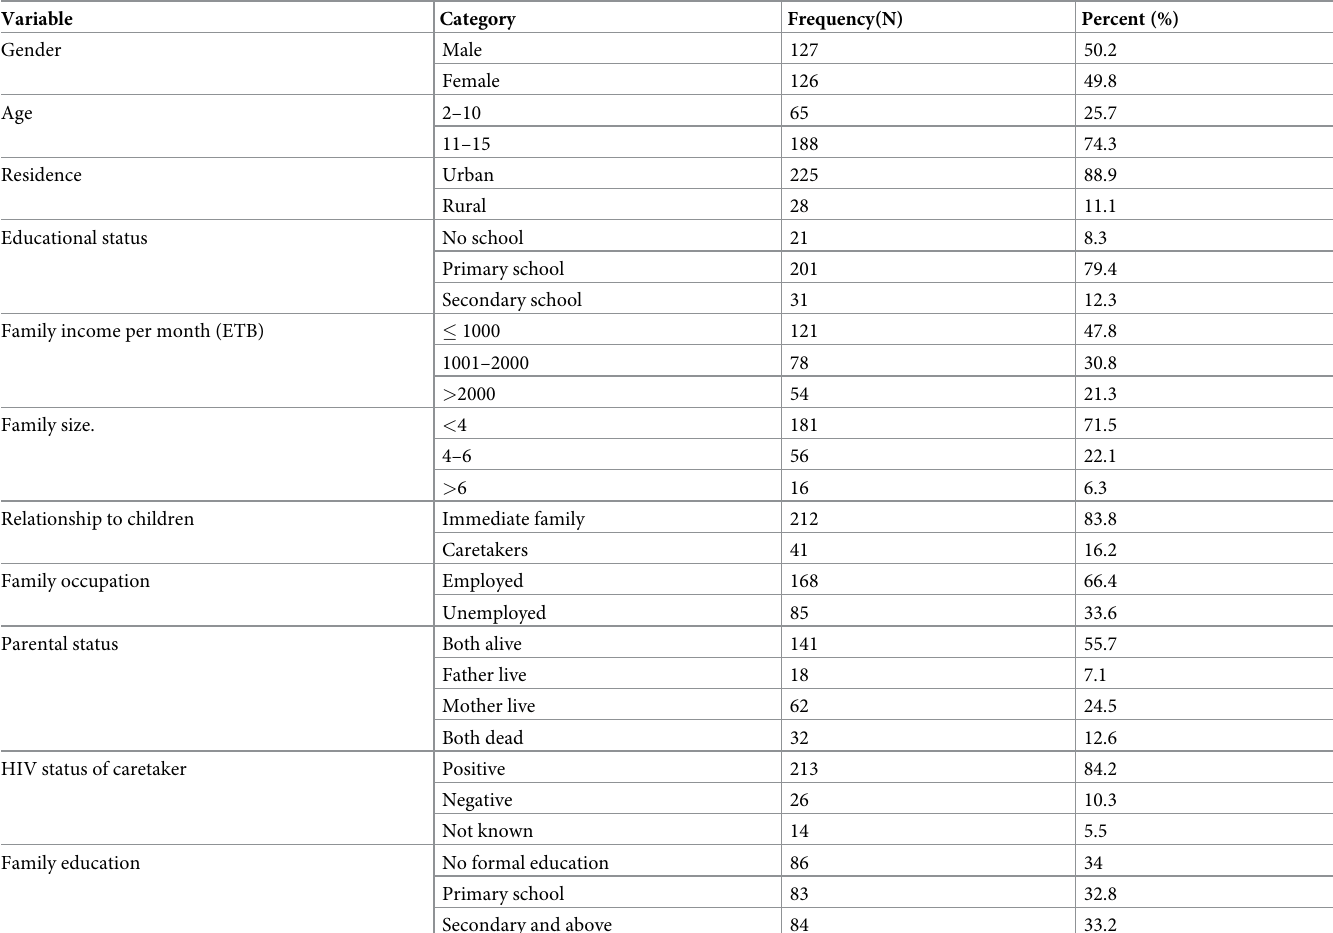
Table 1. Socio-demographic characteristics of ART experienced children and their family /caretaker visiting UoGCSH ART clinic, Northwest Ethiopia,